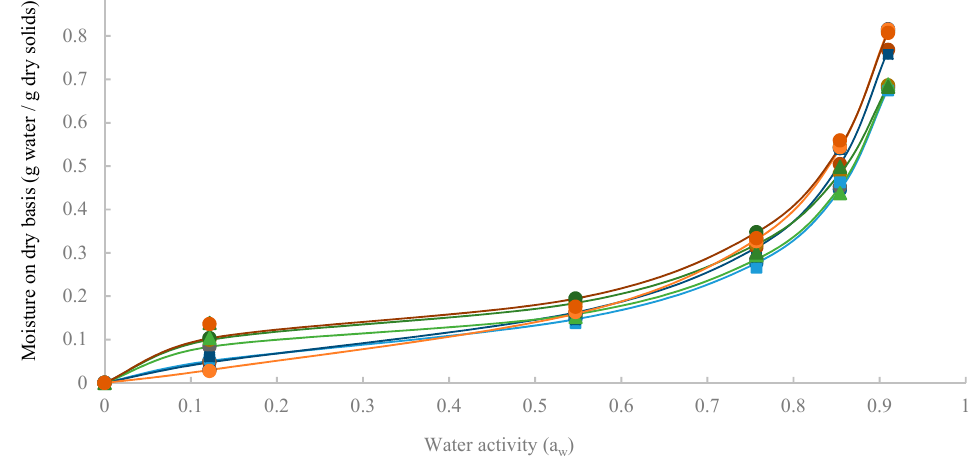
Figure 3. Water adsorption isotherms of particles obtained at 20 ◦ C. Guggenheim-Anderson-de Boer (GAB) equation (lines). Experimental data: maltodextrin at 150 ◦ C ( (cid:4) ), maltodextrin at 190 ◦ C ( (cid:4) ), inulin at 150 ◦ C ( (cid:78) ), inulin at 190 ◦ C ( (cid:78) ), arabic gum at 150 ◦ C ( • ), and arabic gum at 190 ◦ C ( • ).